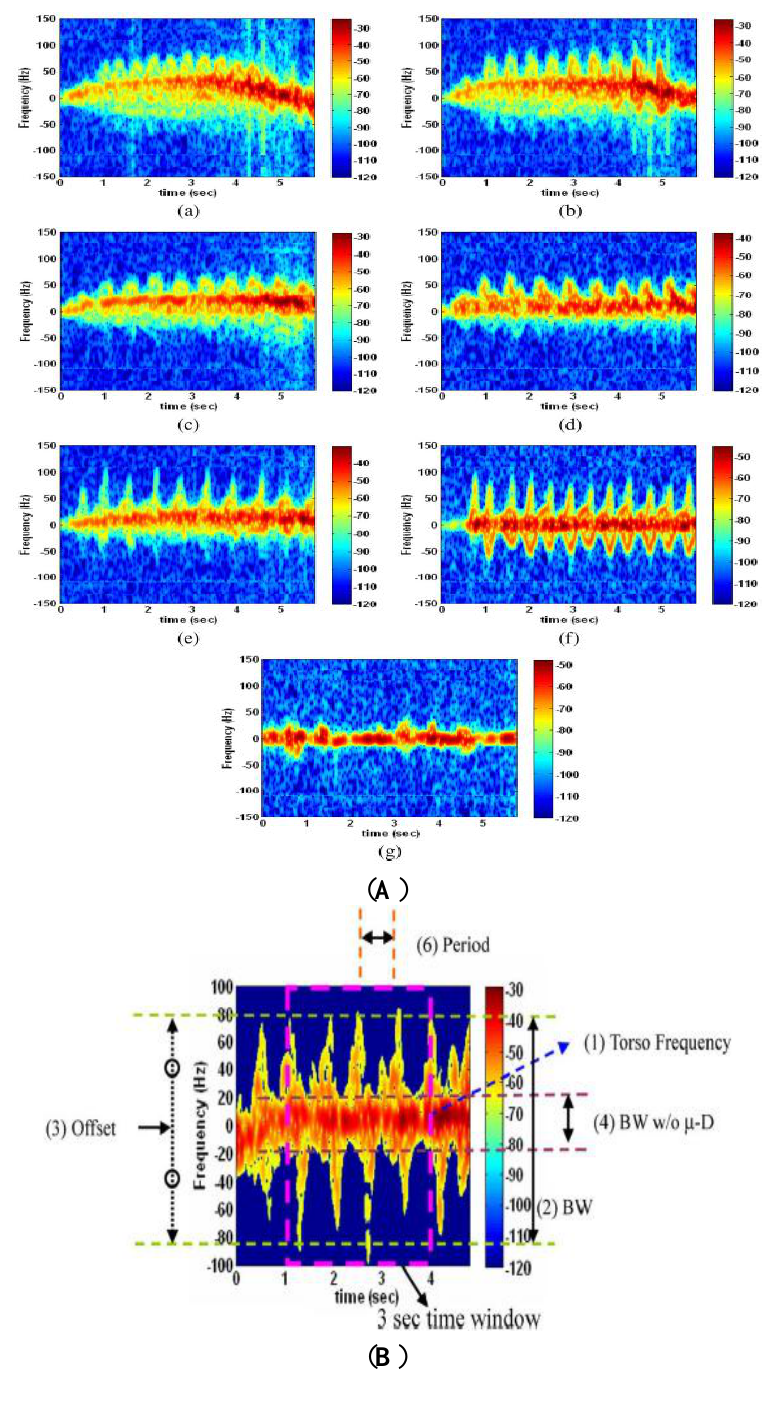
Figure 2. ( A ) Spectrogram of different human activities using micro Doppler signatures: Spectrograms of seven human activities. ( a ) Running, ( b ) Walking, ( c ) Walking while holding a stick, ( d ) Crawling, ( e ) Boxing while moving forward, ( f ) Boxing while standing in place, ( g ) Sitting with slight movements (© 2009 IEEE. Reprinted, with permission, from